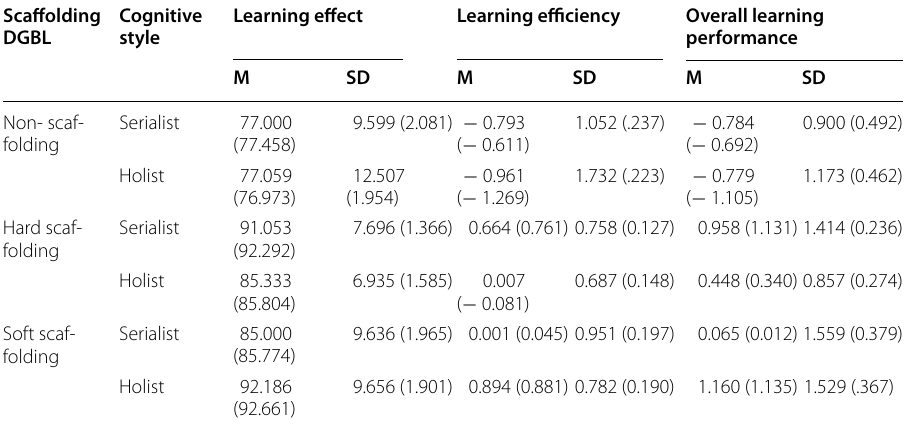
The data in parentheses was adjusted mean and adjusted standardized